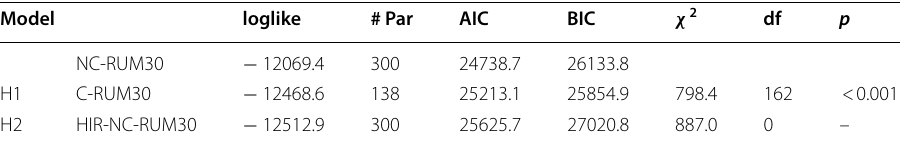
Table 8 Hypotheses testing